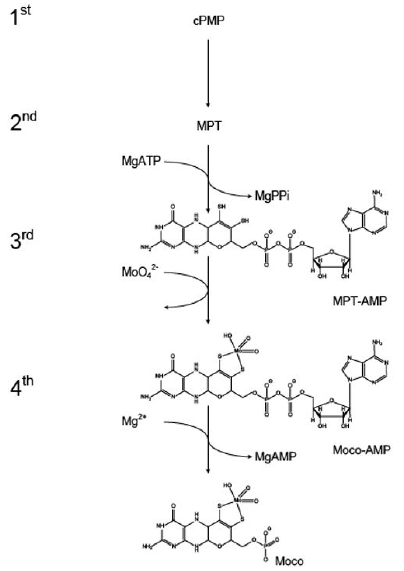
Figure 2. The eukaryotic molybdenum cofactor biosynthesis—intermediates and reaction steps. For clarity the reaction products of the first (cyclic pyranopterin monophosphate, cPMP) and second (molybdopterin, MPT) step are not shown here. The third and fourth steps of Moco biosynthesis are catalyzed by molybdenum-insertases (Mo-insertases). Within the third step of the biosynthesis, the Mo-insertase G-domain adenylates MPT yielding MPT-AMP (termed adenylated MPT [22]), which is the substrate of the Mo-insertase E-domain. In the fourth step of the pathway, molybdate is inserted by the E-domain, yielding Moco-AMP (termed adenylated Moco [14]) which is subsequently hydrolyzed to yield Moco. For a recent summary describing the Moco biosynthesis pathway see Ralf Mendel ´ s review in this Special Issue